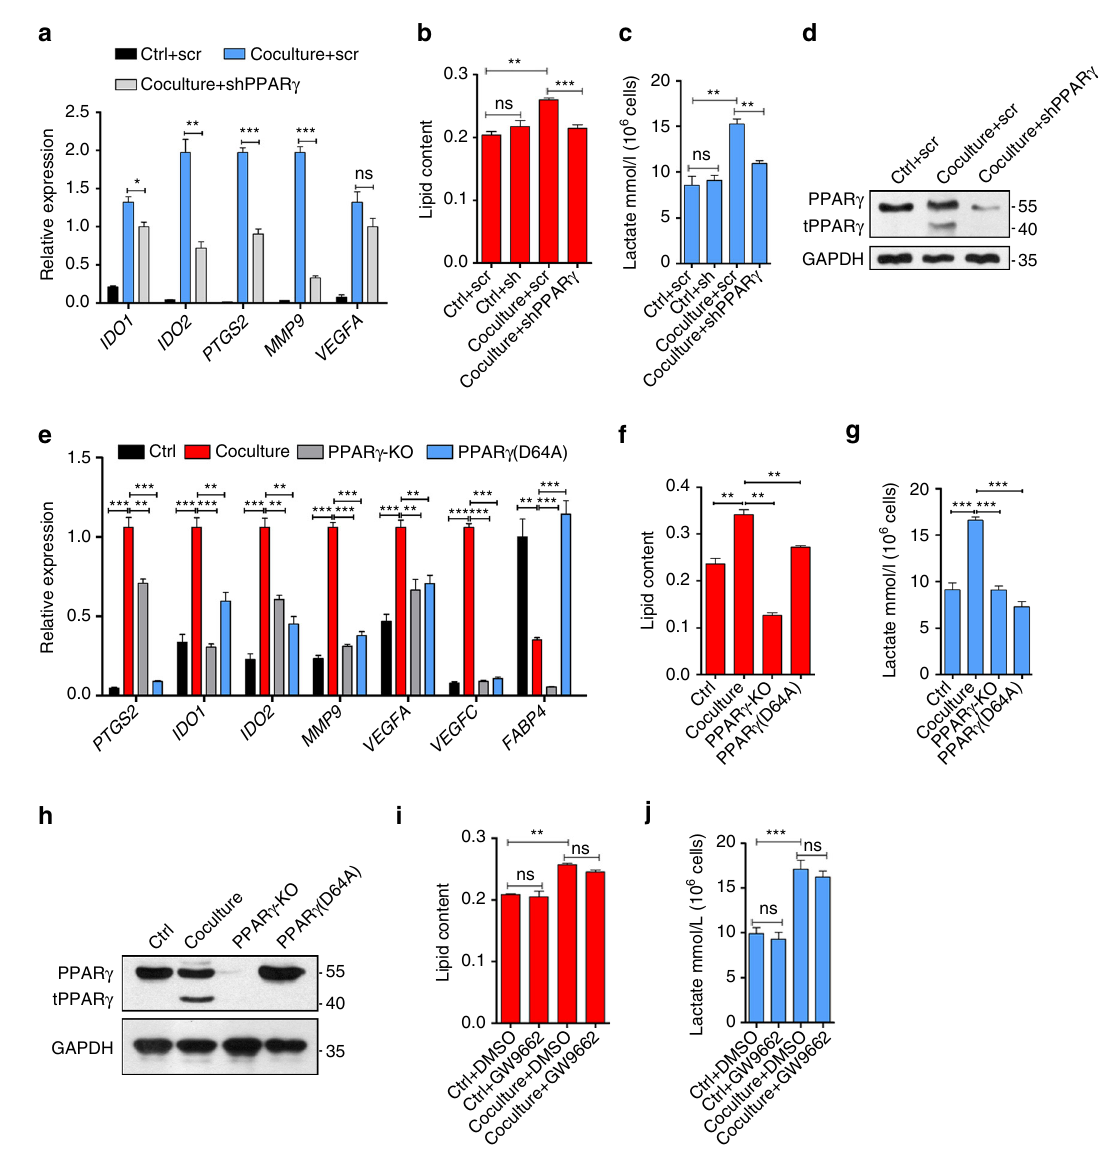
Fig. 5 Loss of function of PPAR γ fails to promote TAM differentiation or metabolic reprogramming in TAMs. a – d THP-1 cells stably expressing control scramble shRNA were cultured alone (Ctrl + scr) or cocultured with MCF-7 (Coculture + scr), THP-1 cells stably expressing shRNA against PPAR γ were cultured alone (Ctrl + shPPAR γ ) or cocultured with MCF-7 (Coculture + shPPAR γ ), after 2 d, TAM hallmarks expression was analyzed by RT-qPCR ( a ), THP-1 macrophages were stained with Oil Red O and lipid content was quanti fi ed ( b ), or MCF-7 and regular culture medium was replaced with 2 ml fresh culture medium then culture for another 24 h, the lactate concentration were measured ( c ), PPAR γ and its fragment were analyzed by immunoblot ( d ). e - h THP-1 cells stably expressing LacZ were cultured alone or cocultured with MCF-7, PPAR γ knockout THP-1 cells or THP-1 cells that express PPAR γ (D64A) were cocultured with MCF-7, after 2 d, TAM hallmarks expression was analyzed by RT-qPCR ( e ), THP-1 macrophages were stained with Oil Red O and lipid content was quanti fi ed ( f ), or MCF-7 and regular culture medium was replaced with 2 ml fresh culture medium then culture for another 24 h, the lactate concentration was measured ( g ), PPAR γ and its fragment were analyzed by immunoblot ( h ). i , j THP-1 macrophages were cultured alone (Ctrl) or cocultured with MCF-7 (Coculture) in the presence or absence of PPAR γ inhibitor GW9662. After 2 days, THP-1 macrophages were stained with Oil Red O and lipid content was quanti fi ed ( i ), or MCF-7 and regular culture medium was replaced with 2 ml fresh culture medium then culture for another 24 h, the lactate concentration was measured ( j ). All the histograms in this fi gure show means ± s.e.m. ( n = 3, * P < 0.05, ** P < 0.01, *** P < 0.001, ns, not signi fi cant, one way ANOVA for multiple